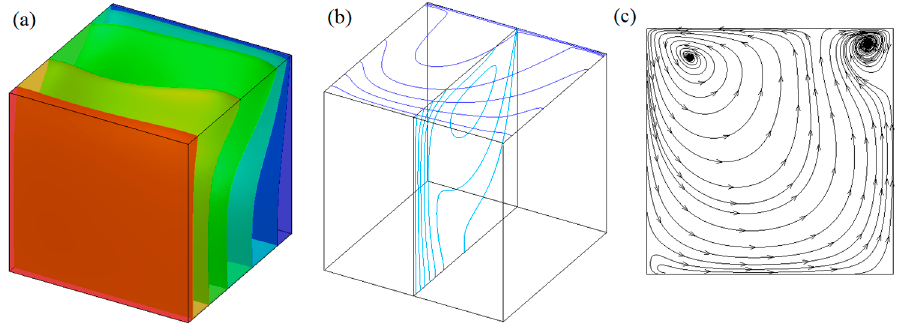
Figure 2. Iso-surfaces of the temperature field ( a ) and concentration field ( b ), streamlines on the mid-y-z plane ( c ) at the simulation condition that Re T = 200, Le = 10.